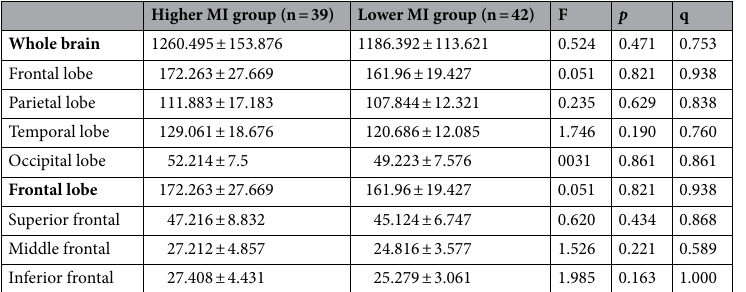
Table 4. Comparison of volume of the whole brain, each brain lobe, and frontal lobe between the higher and lower MI groups. Values reported as mean ± standard deviation. MI = motor improvement. R = right, L = left.